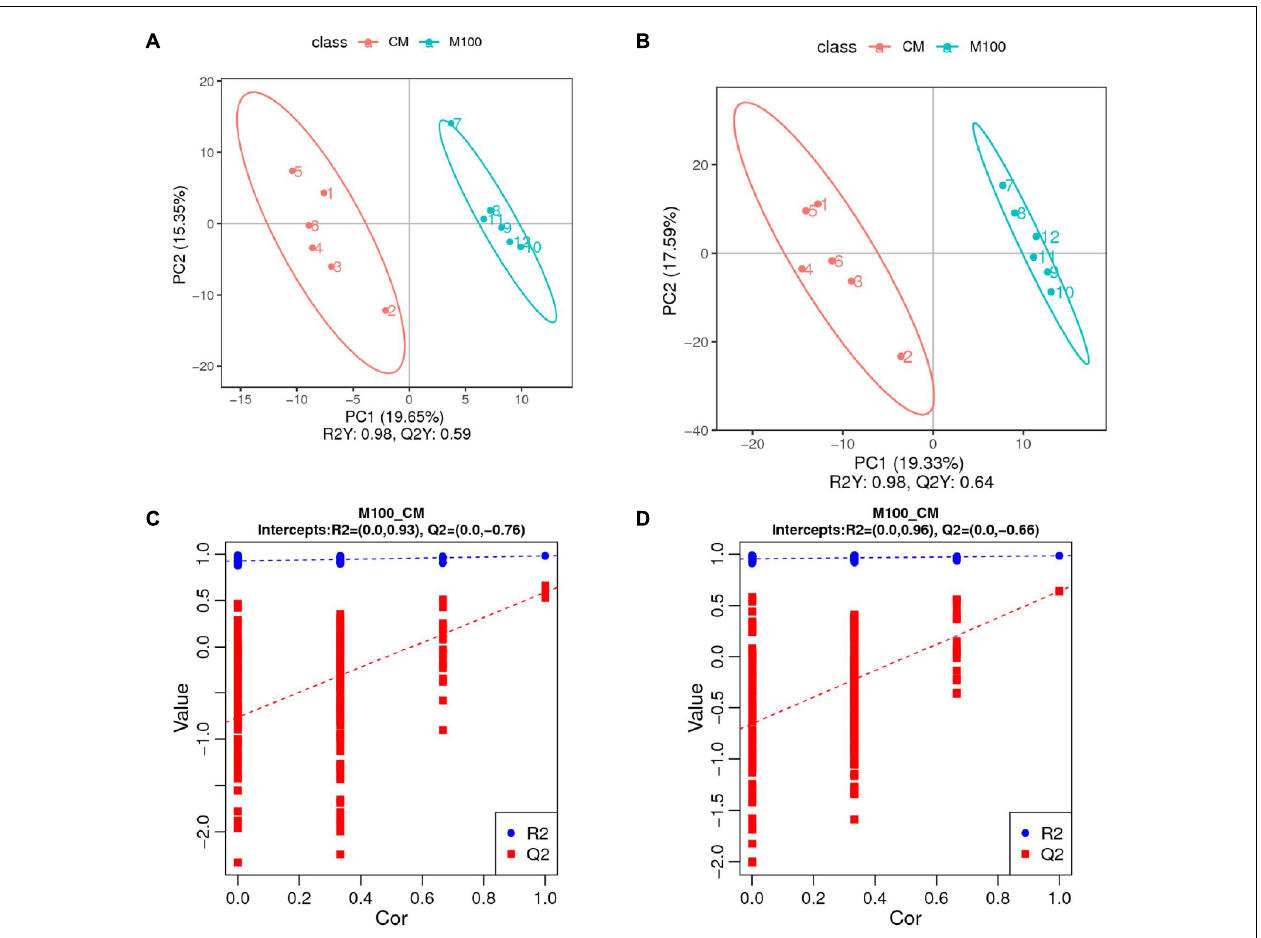
FIGURE 3 | Quality analysis of metabolomic data. (A) OPLS-DA (orthogonal partial least-squares-discriminant analysis) score diagram for the positive ion mode. (B) OPLS-DA score diagram for the negative ion mode. (C) OPLS-DA permutation test for the positive ion mode. (D) OPLS-DA permutation test for the negative ion